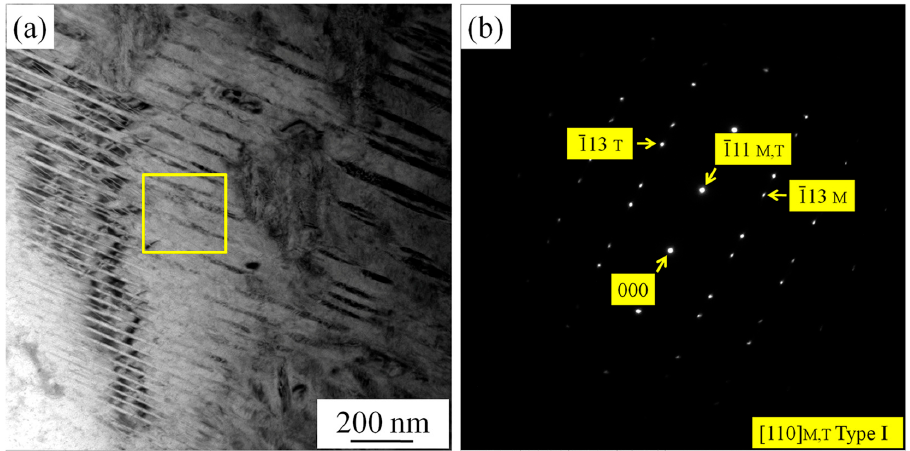
Figure 7. TEM micrographs of NiTiCu SMA subjected to compression deformation at 900 °C: ( a ) Bright field image showing the existence of martensite twins; ( b ) Diffraction pattern of (a).